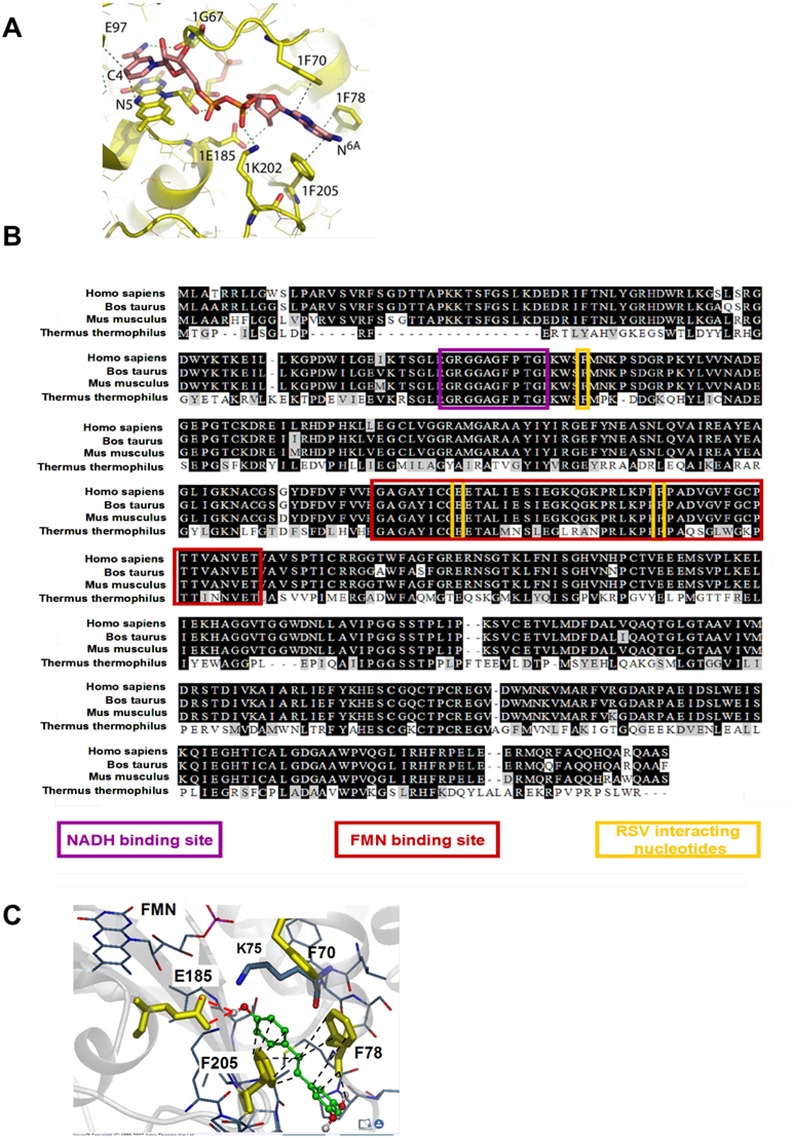
RSV binds to complex I at the nucleotide binding site.
(A) NADH binding site of complex I, according to Sazanov et al. [37]. The bound NADH molecule is colored in pink. The FMN and amino acids that interact with the bound nucleotide are colored in yellow. The hydrophobic stacking interactions between the three phenylalanines and the adenosine moiety are represented by dashed gray lines. (B) Boxshade alignement of the amino acid sequence of NDUFV1 (human nomenclature) from Homo sapiens, Bos taurus, Mus musculus and Thermus thermophilus showing the conservation of the NADH and FMN binding sites. The conserved amino acids are highlighted in dark, the NADH binding site is boxed in purple, the FMN binding site in red, and the amino acids interacting with RSV are boxed in yellow. (C) Occlusion of the flavin site through the binding of NAD(H) or RSV. RSV bound to active FMN site in complex I from Thermus thermophilus (Protein Data Bank ID: 3IAM). The FMN and bound nucleotide are shown as sticks. RSV is colored in green. Amino acids that interact with the bound nucleotide are colored in yellow, with hydrogen bonding interactions shown by dashed red lines and hydrophobic stacking interactions by dashed dark lines.